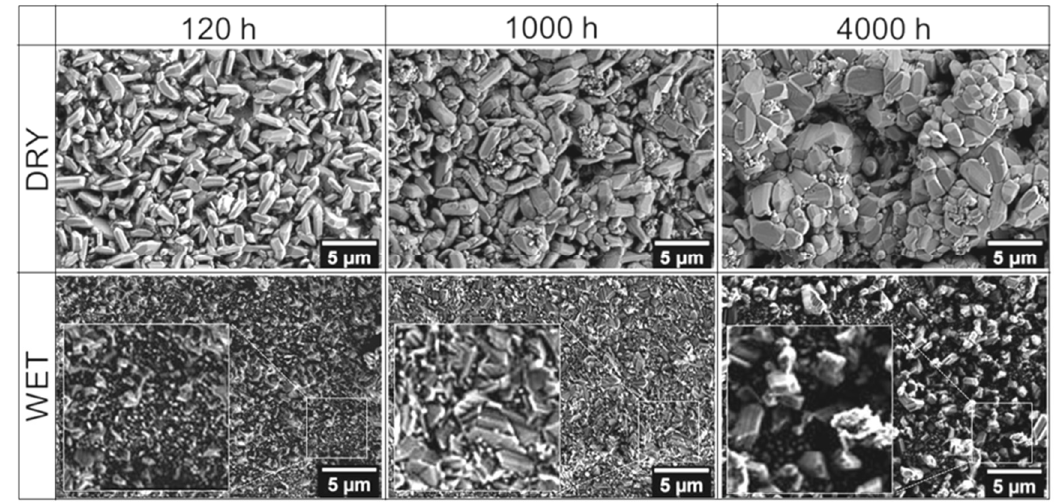
Figure 3. Morphology of the oxide scale on the 718Plus superalloy after oxidation at 850 °C for 120, 1000 and 4000 h in dry and wet air; SEM-SE images.